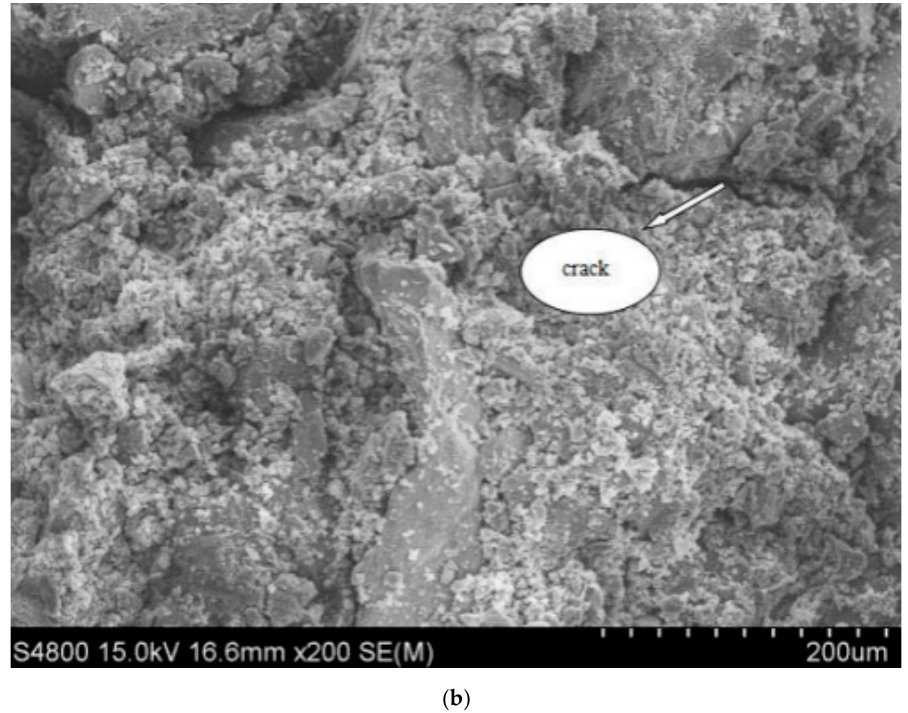
Figure 8. Micromorphology of CPB. ( a ) Magnified 200 times and ( b ) Magnified 50 times.